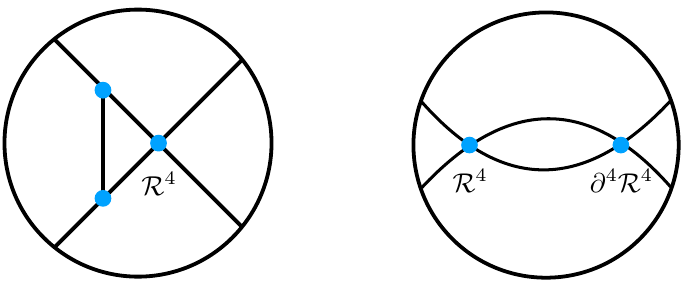
Figure 1. Two contributions to the genus-one AdS amplitude. The respective sums in (3.9) compute their